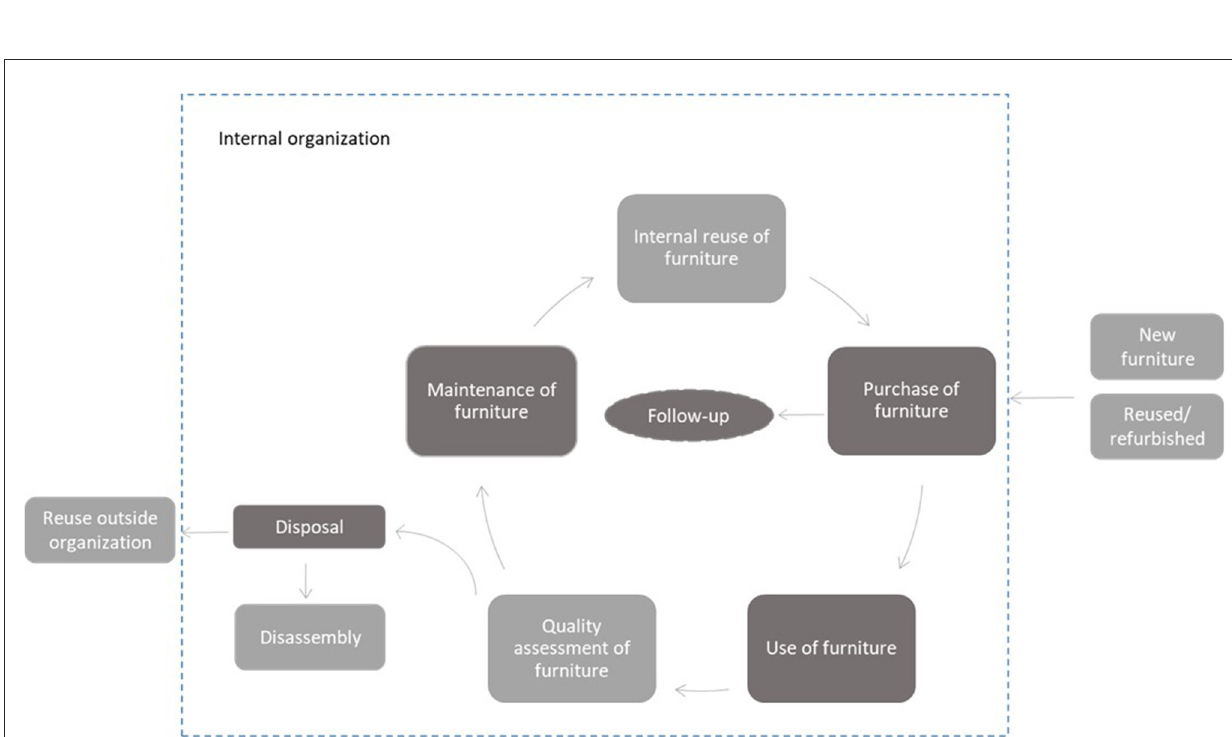
FIGURE1 Illustration of the circular furniture flows, where darker boxes indicate the main stages. Purchase of furniture: (1) internal reuse, (2) external reuse, and (3) external new. Use of furniture: products in use. Quality assessment of furniture: (1) maintenance of furniture, and (2) disposal. Disposal of furniture: (1) disposal and disassembly in fractions for recycling or landfill, and (2) external reuse and potential later recycling. Maintenance of furniture: (1) no action, (2) reconditioning, (3) renovation, and (4) re-design, e.g., repainting. Internal reuse: (1) intermediate storage, and (2) direct reuse. Follow-up: performed yearly for